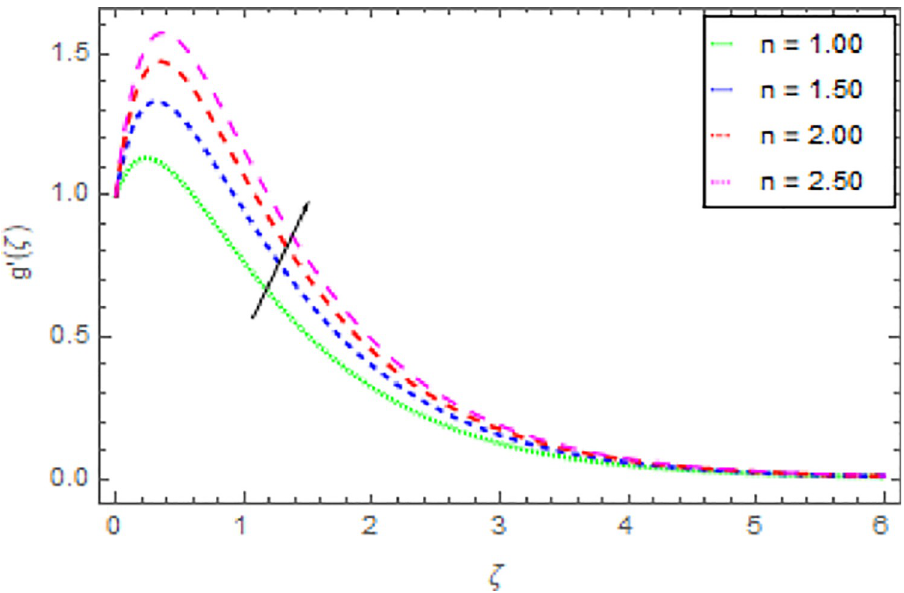
Fig 7. Deviation in nanofluid velocity ( y − direction) against n when Pr = 1000, m = 0.10, M = 2.50, δ = 0.40, β = 1.00, Nr = 0.20 and ϕ = 0.01 to ϕ = 0.04.